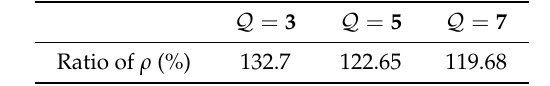
Table 6. Optimization of service guarantee